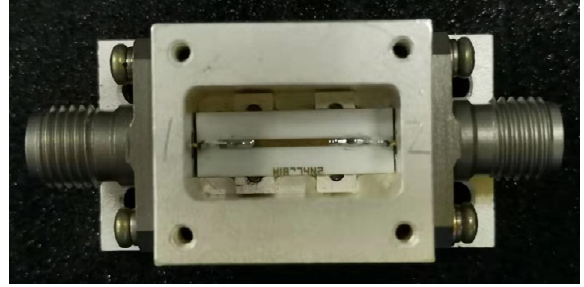
Figure 5. Photograph of the fabricated FCWI-to-FCWI.